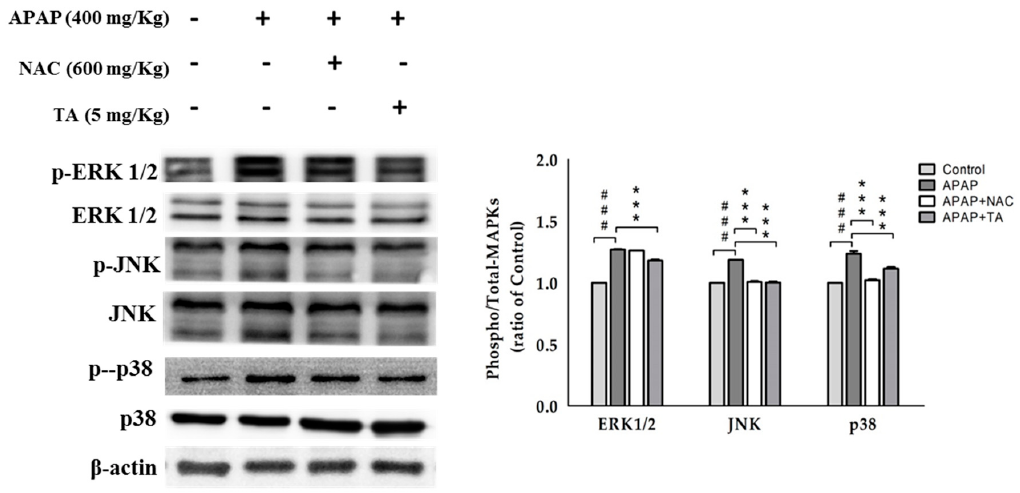
Figure 8. TA inhibited MAPK expression in APAP-induced mice. β -actin served as a loading control. The values are reported as the means ± S.E.M. of five mice per group. ### p < 0.01 compared with the control group; *** p < 0.001 compared with the APAP group.